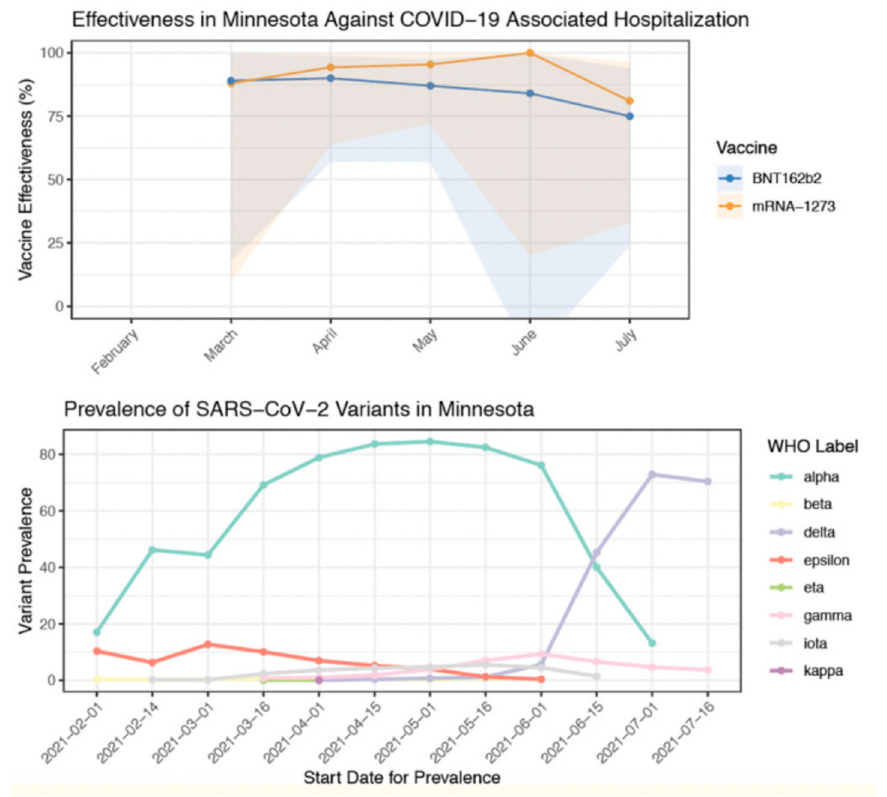
Figure 3. Decrease in Vaccine Efficacy Against Delta (B.1.617.2) Variant